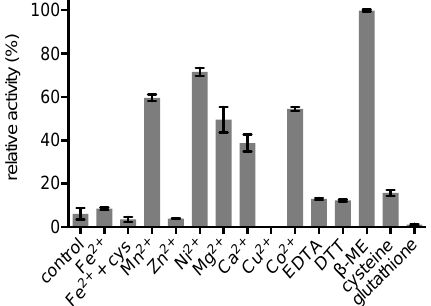
Figure 5. Effect of metal ions, chelating and reducing agents on the activity of TaManD. Purified enzyme (0.6 µ g) was pre-incubated for 1 h with 1 mM of each additive in 50 mM HEPES pH 7. Activity was then determined in reactions containing 10 mM D-mannono-1,4-lactone in 50 mM HEPES pH 7 incubated for 1 h at 55 ◦ C before analysis with the semicarbazide assay. Activity is expressed in relation to the maximum enzyme activity. Fe 2+ + cys: Fe 2+ was prepared with 1 mM cysteine. DTT: